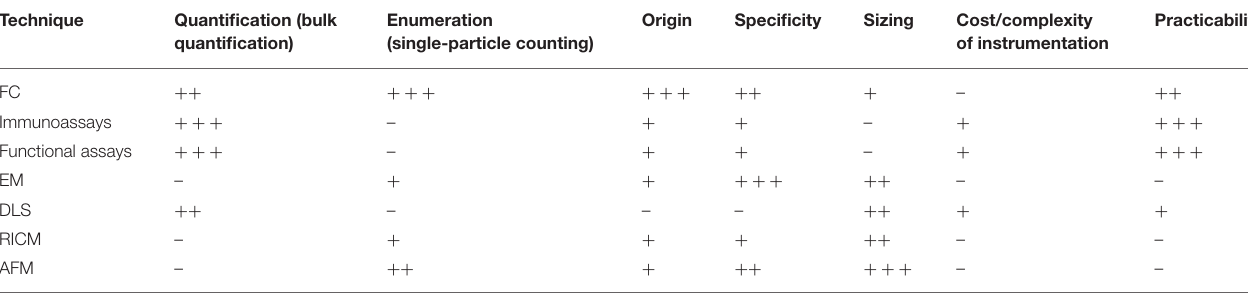
TABLE 1 | Profiles of multiple techniques for detection and characterization of MPs.